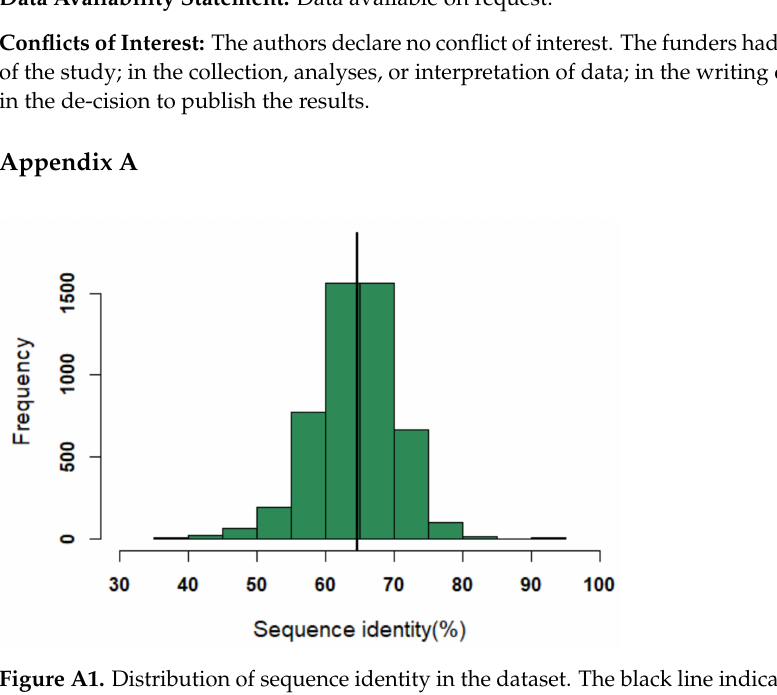
Figure A1. Distribution of sequence identity in the dataset. The black line indicates the median value of the distribution (i.e., sequence identity of